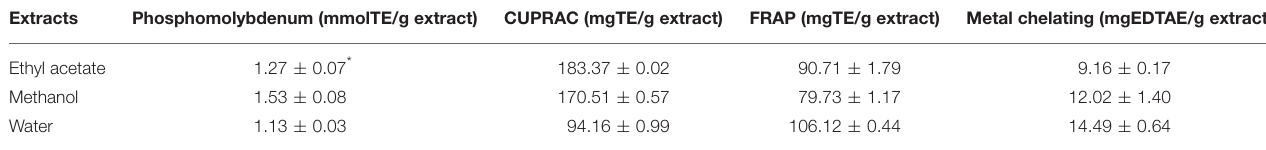
TABLE 5 | Total antioxidant capacity (phosphomolybdenum assay), reducing power (CUPRAC and FRAP assays) and metal chelating activities of the extracts. Extracts Phosphomolybdenum (mmolTE/g extract) CUPRAC (mgTE/g extract) FRAP (mgTE/g extract) Metal chelating (mgEDTAE/g extract) Ethyl